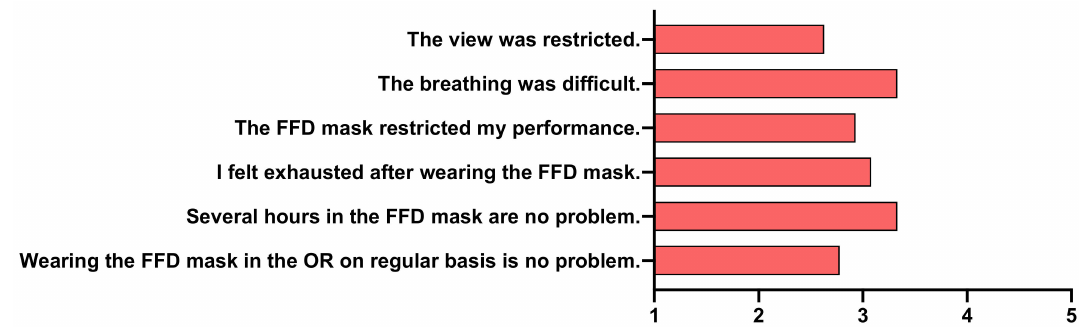
Figure 5. Full-face diving mask questionnaire. Mean Likert score values for each question are shown as bars. FFD, full-face